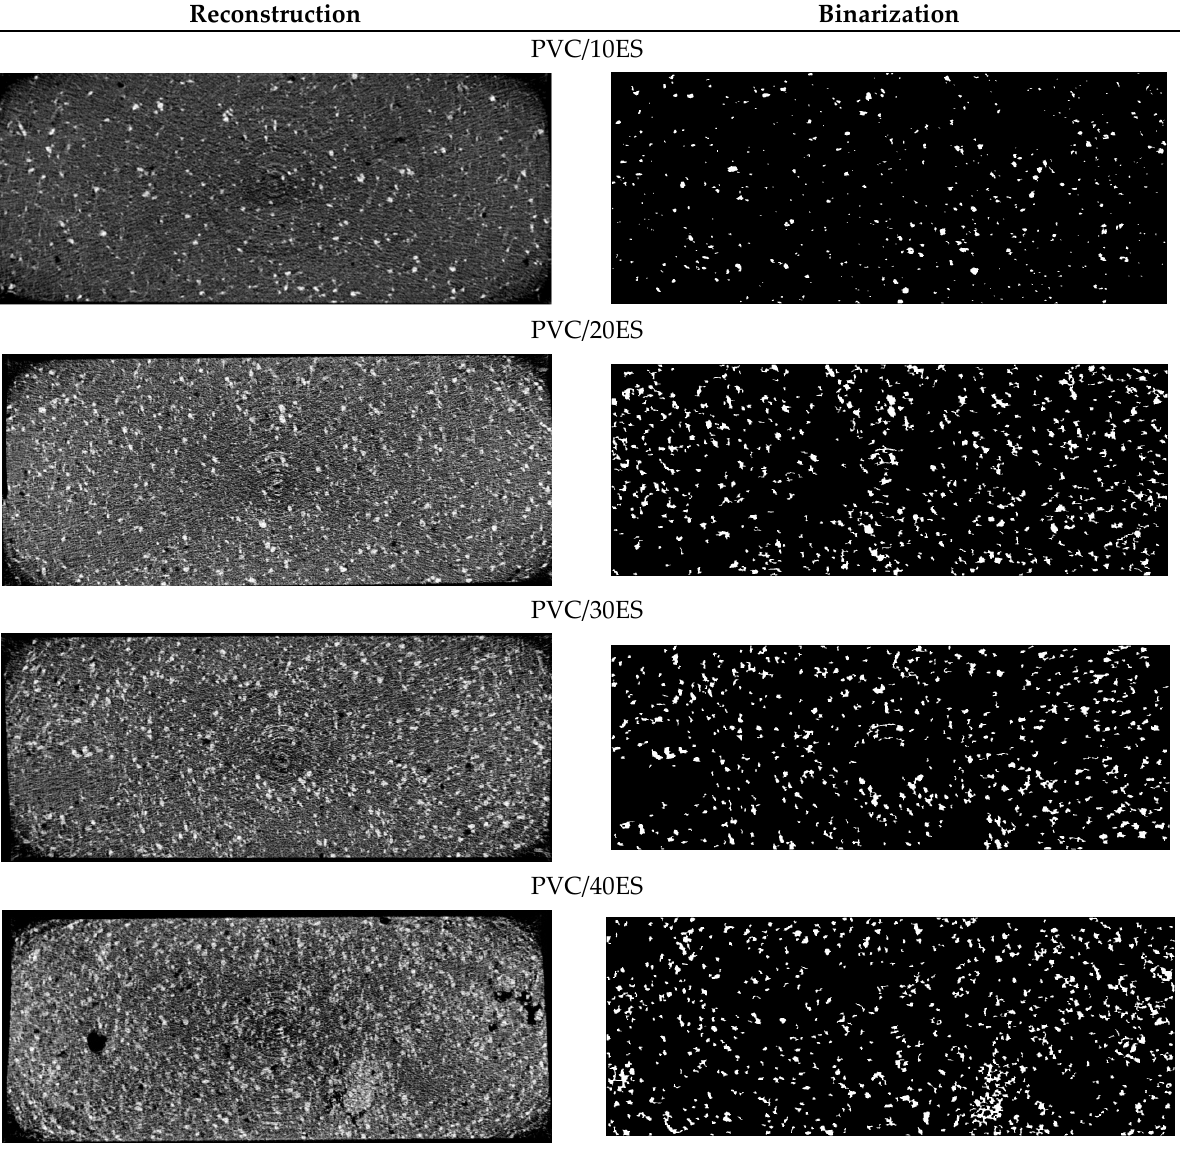
Table 6. Average ES particle size obtained with 3D analysis by the CTAn program.